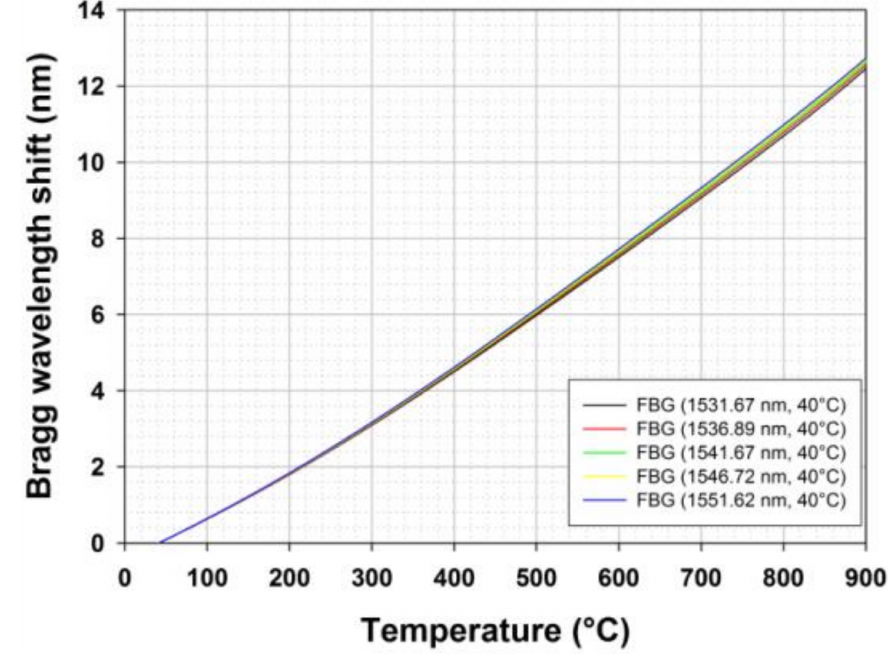
Figure 3. Bragg wavelength shift with temperature up to 900 ◦ C for five regenerated FBGs realized and calibrated at CEA List laboratory. The seed FBGs were written using a 244 nm continuous-wave Argon Ion laser (Fred Innova 300C from Coherent) into H 2 -loaded smf-28 optical fibre. Regeneration was performed at 910 ◦ C in a tubular